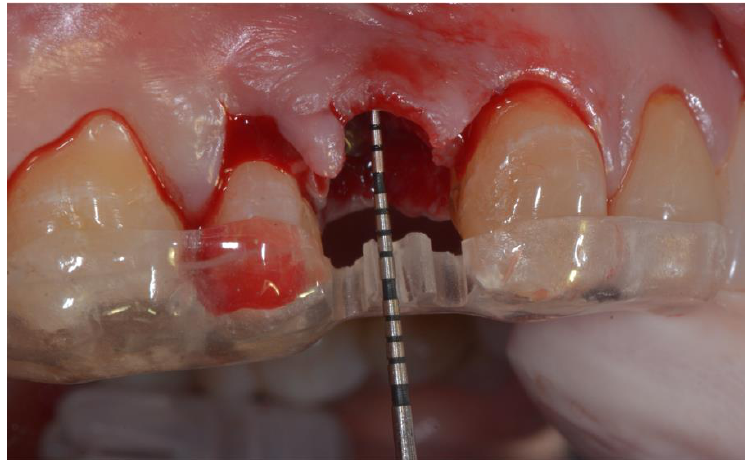
Figure 1. Fresh extraction socket: positioning of a custom acrylic template used to take the horizontal and vertical bone measurements during the surgery (T0).